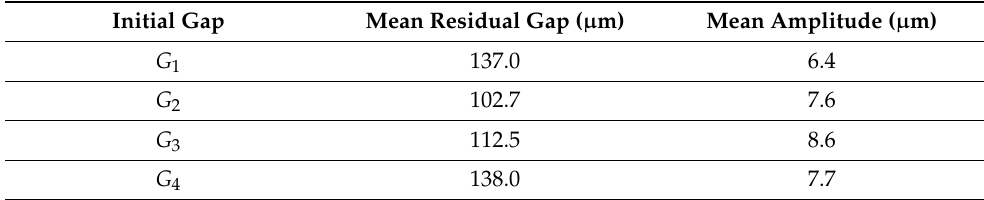
Table 1. Parameters of the residual gap in the drilling point.